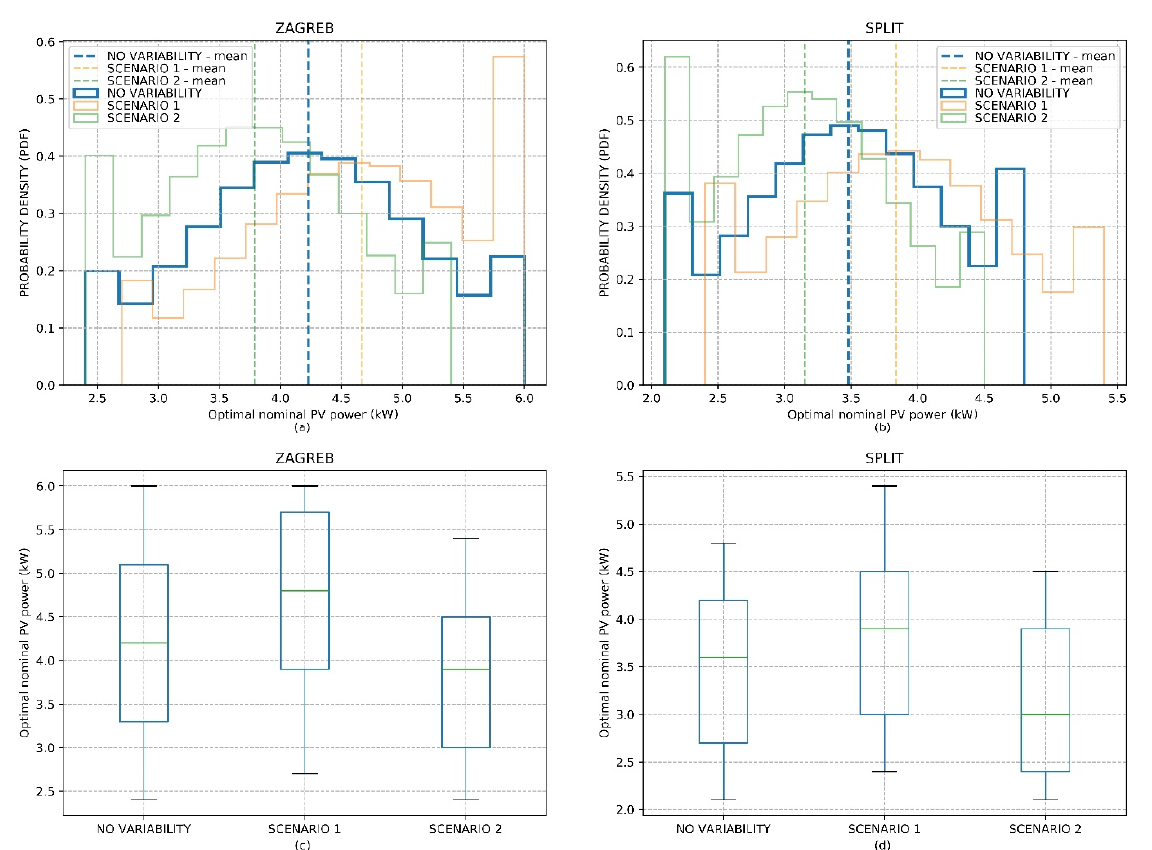
Figure 13. ( a ) Gaussian distribution of optimal powers with mean values for Zagreb. ( b ) Gaussian distribution of optimal powers with mean values for Split. ( c ) Boxplot diagram of optimal powers with interquartile range for Zagreb. ( d ) Boxplot diagram of optimal powers with interquartile range for Split.